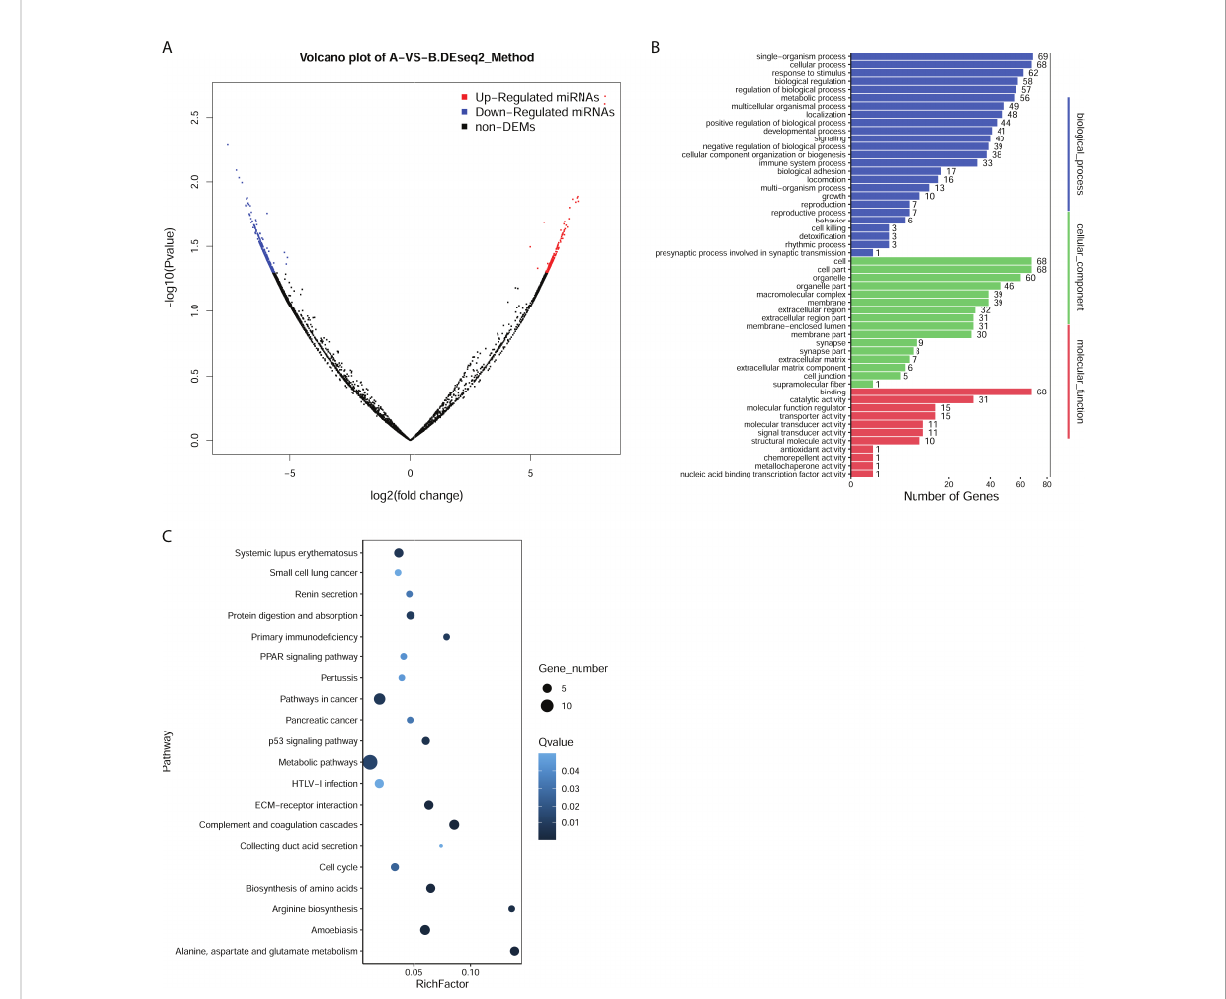
FIGURE 2 Identi fi cation and function enrichment analysis of differentially expressed miRNAs (DEMs) in exosomes from cholangiocarcinoma (CHOL) compared to healthy controls. (A) Volcano plot of exosomal DEMs between CHOL and control samples. (B) Gene Ontology (GO) enrichment analyses for target genes of DEMs. (C) Kyoto Encyclopedia of Genes and Genomes (KEGG) pathway enrichment analyses for target genes of